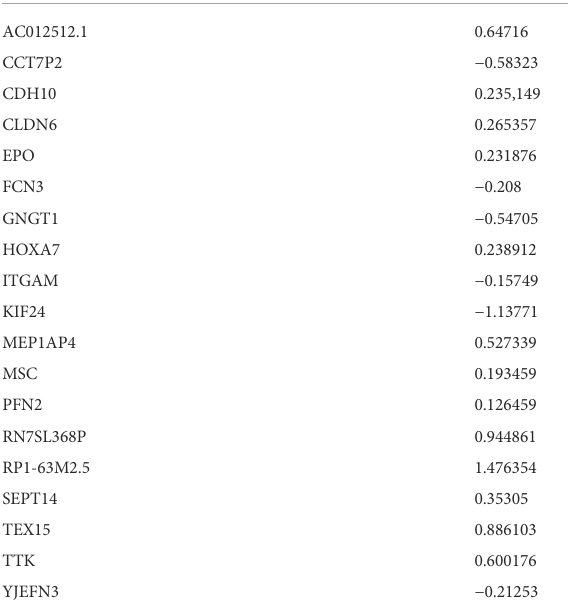
TABLE 1 Signi fi cant prognostic DEGs and their corresponding coef fi